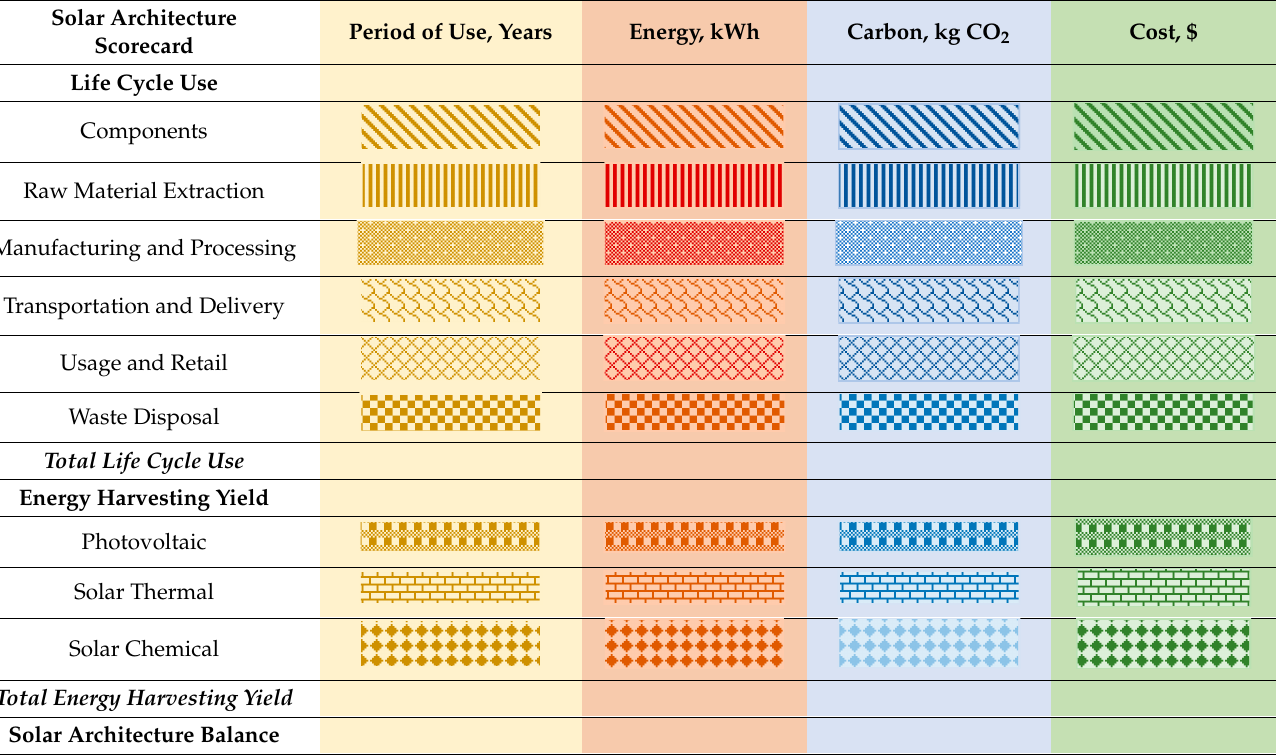
Table 1. Solar Architecture Table template.